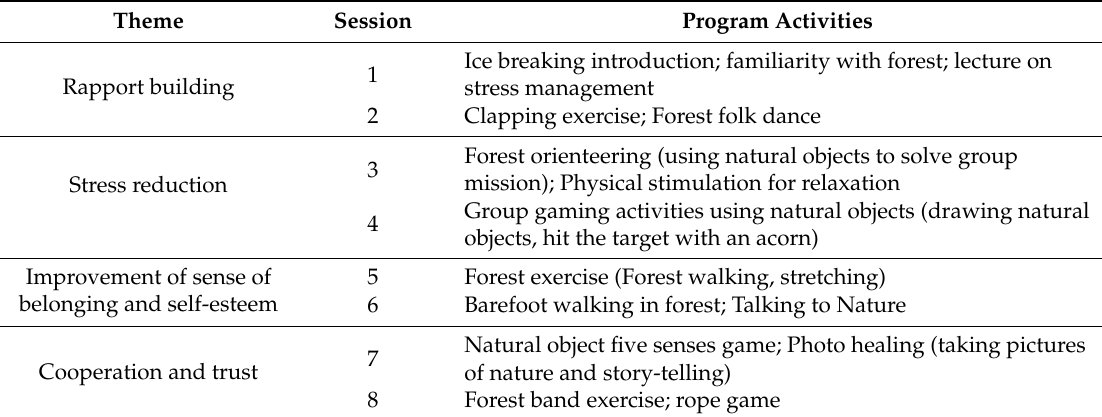
Table 1. Themes and Activities of the Forest Therapy